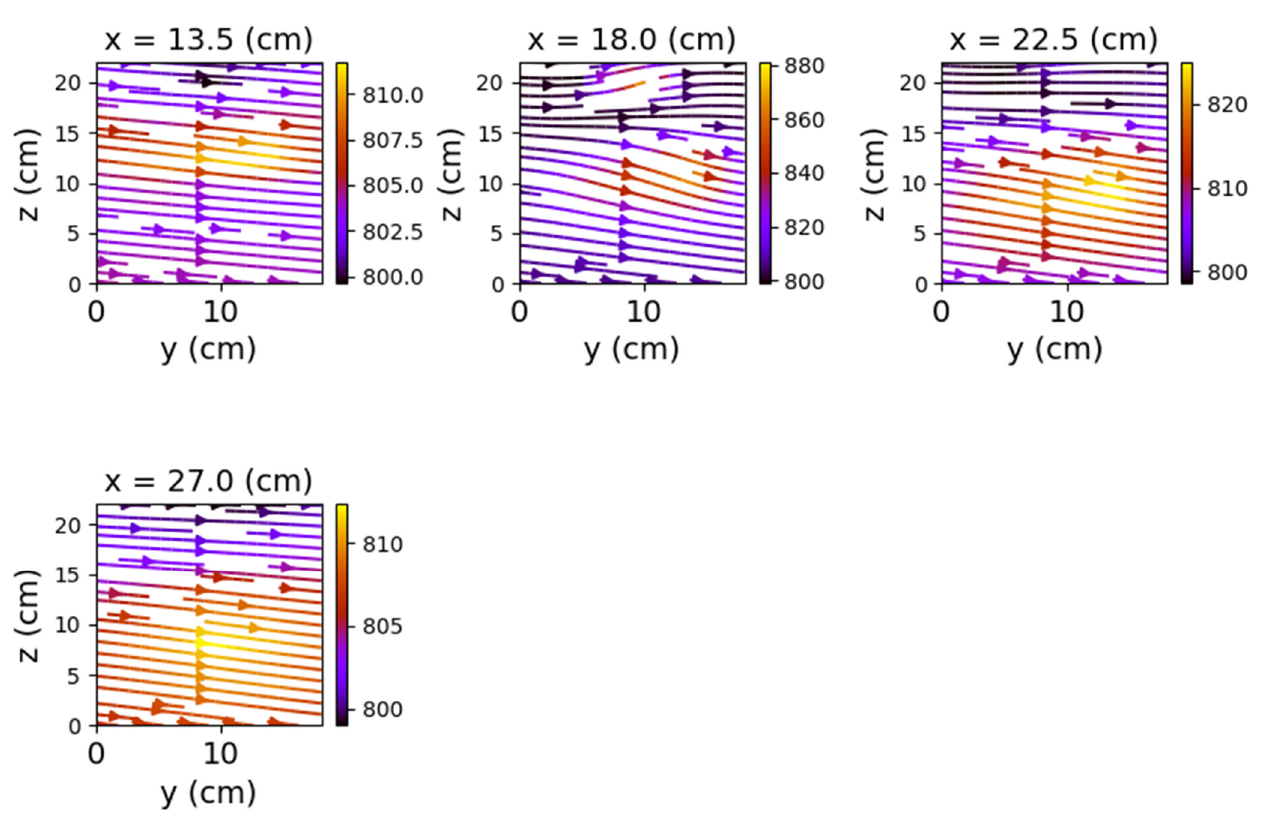
Figure 12. Field lines for y O z plane—relay with both coils powered.